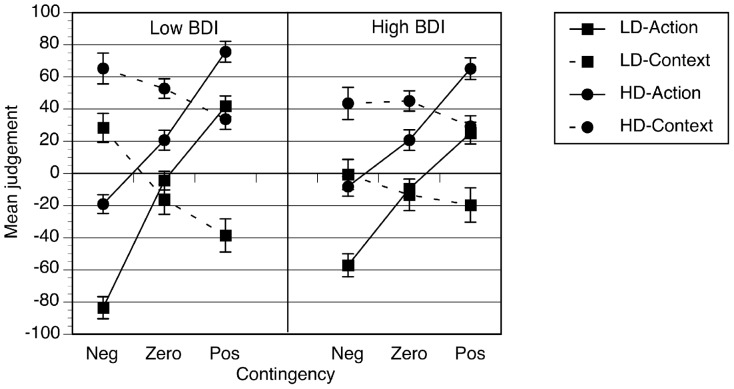
Ratings of the causal strength of the action and the context.Error bars correspond to the standard error of the mean. NB: LD  =  low outcome density, HD  =  high outcome density, Neg  =  negative contingency, Zero  =  zero contingency, Pos  =  positive contingency.